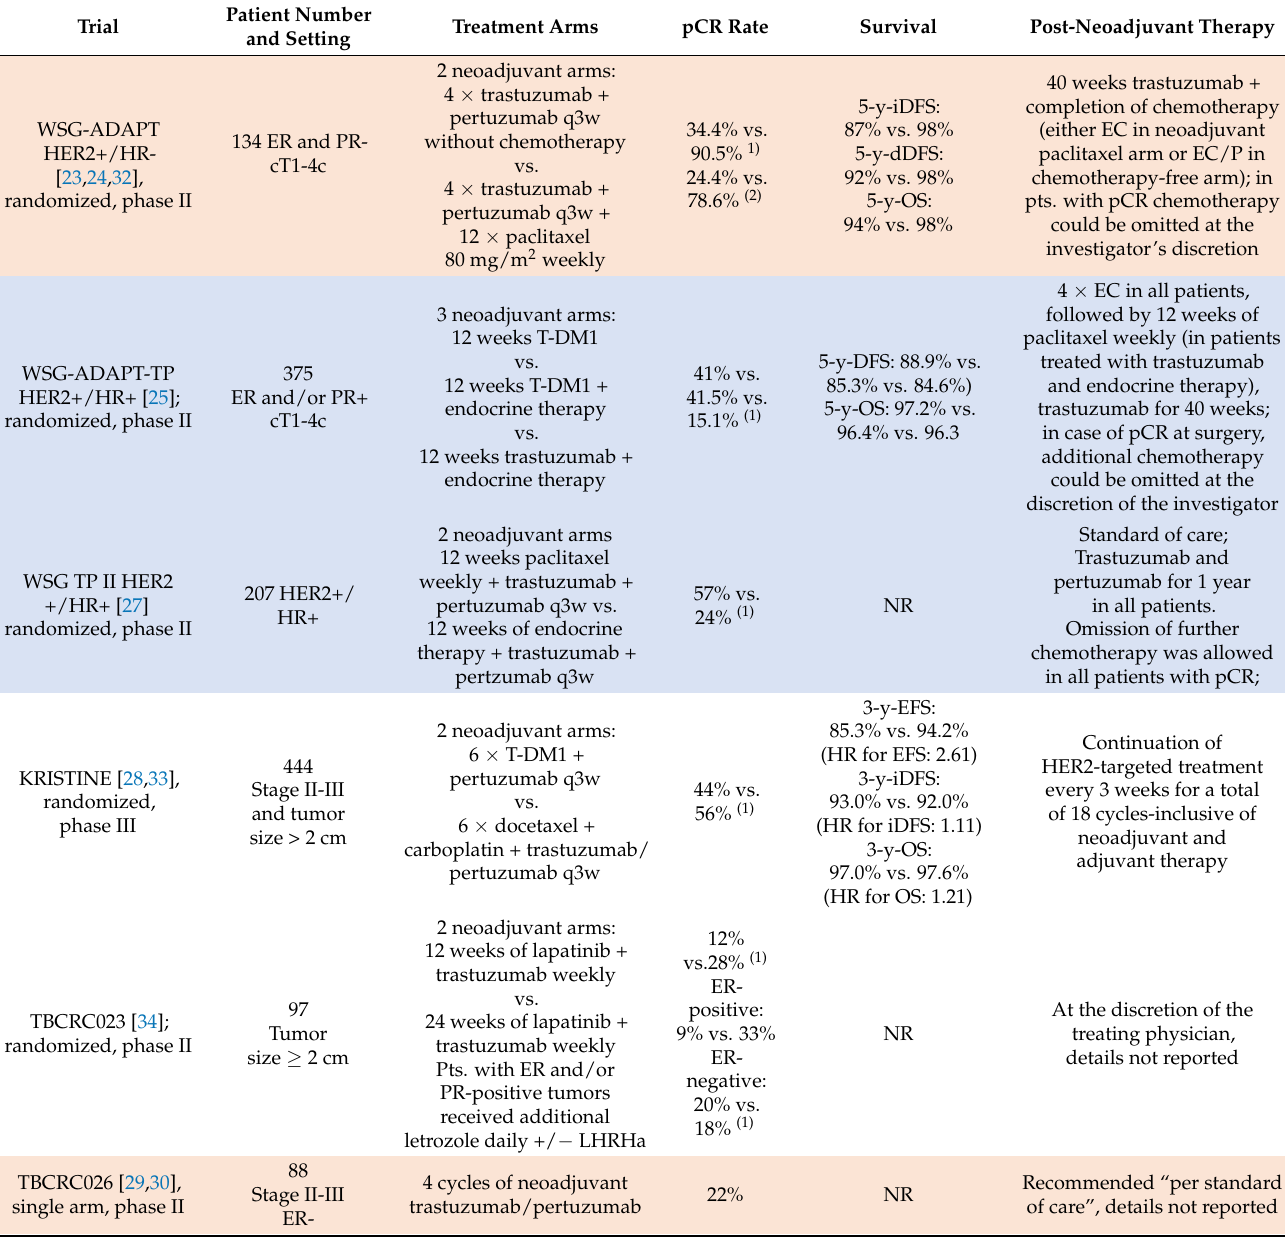
Table 2. Clinical studies investigating treatment de-escalation in HER2-positive non-metastatic breast